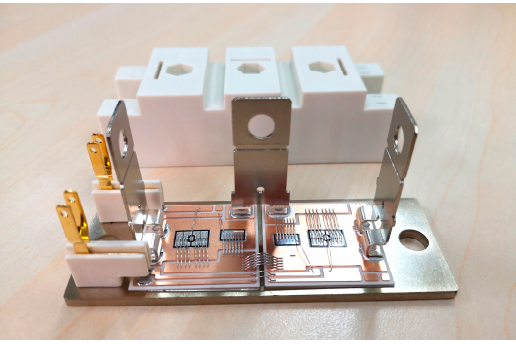
Figure 8. The insulated gate bipolar transistor (IGBT) module used in the experiment.